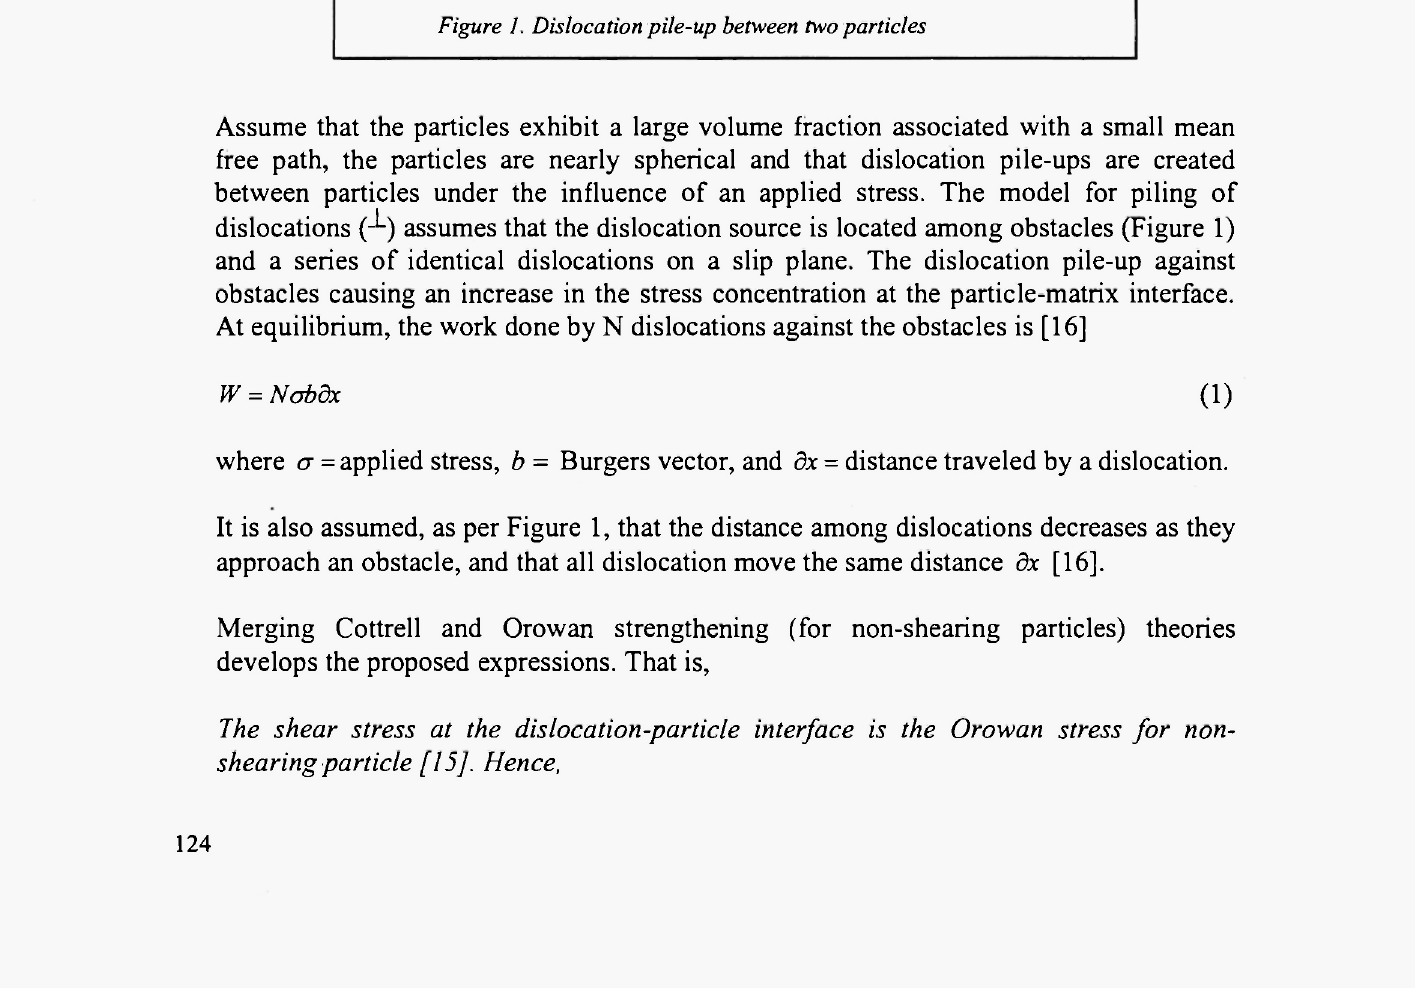
Figure 1. Dislocation pile-up between two